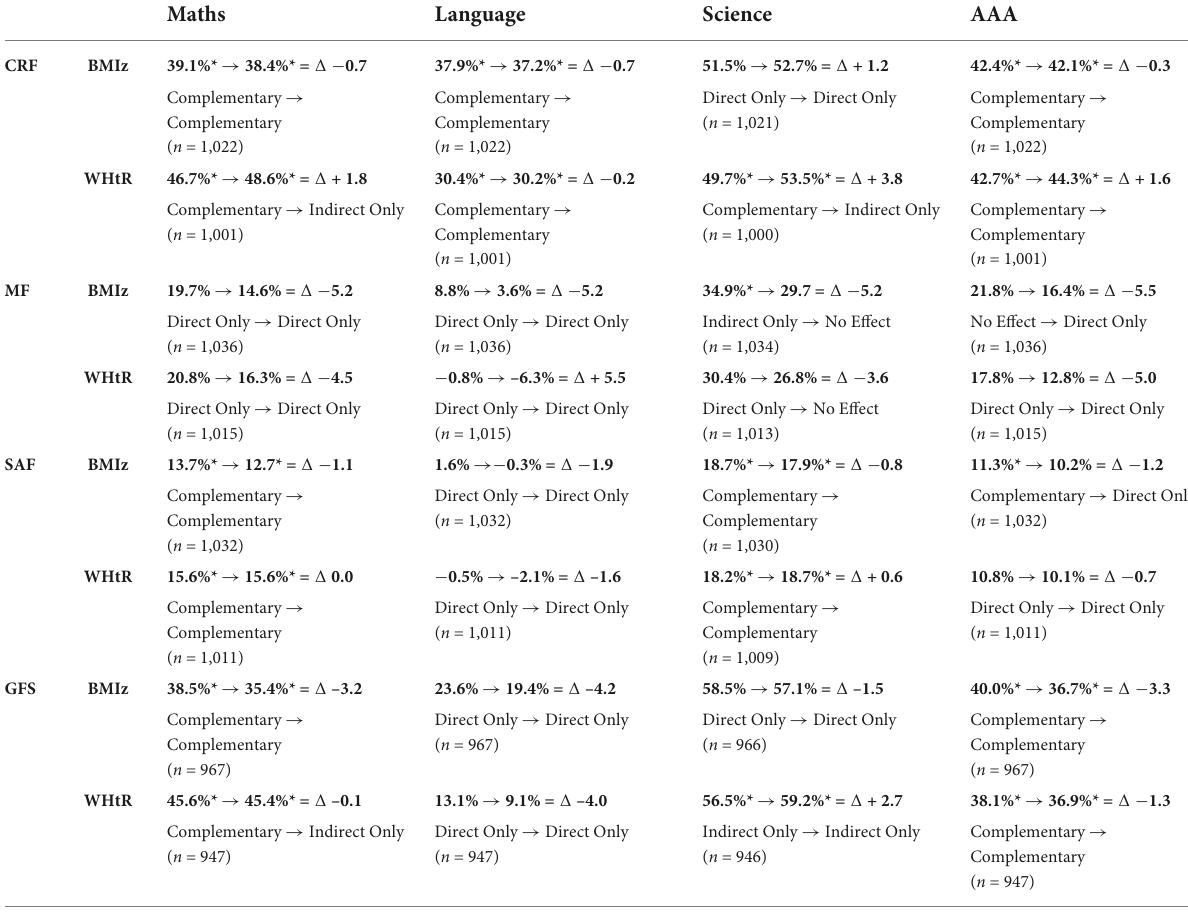
TABLE 3 Findings summary concerning the direct and indirect effects according to both models. Percentage of mediation and classification.